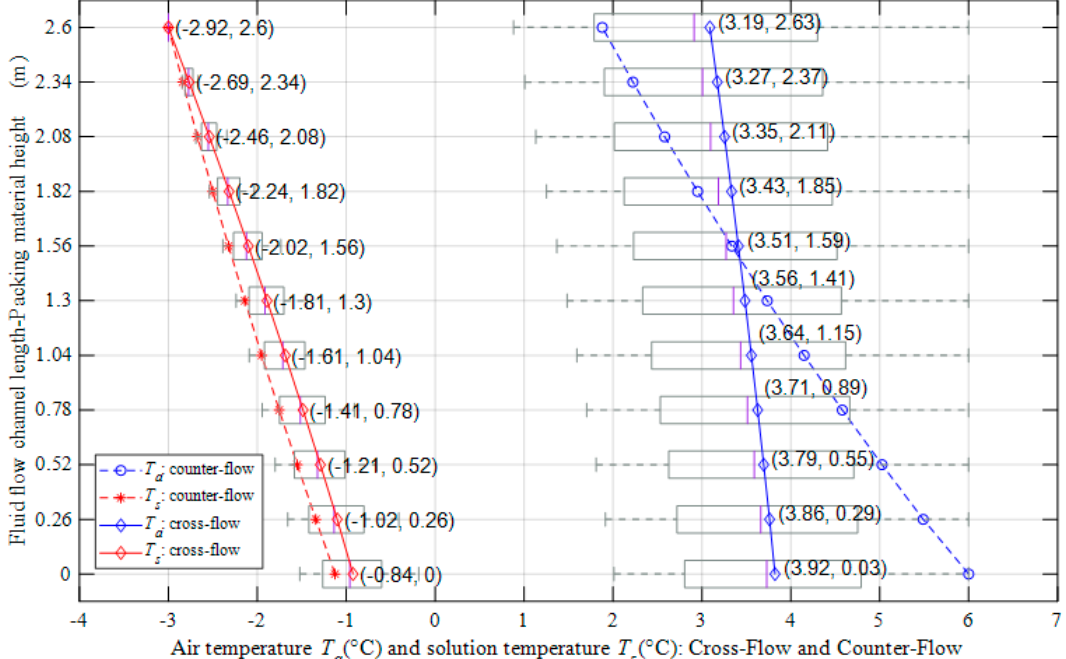
Figure 8. Variation of fluid temperature within the fluid flow channel length.